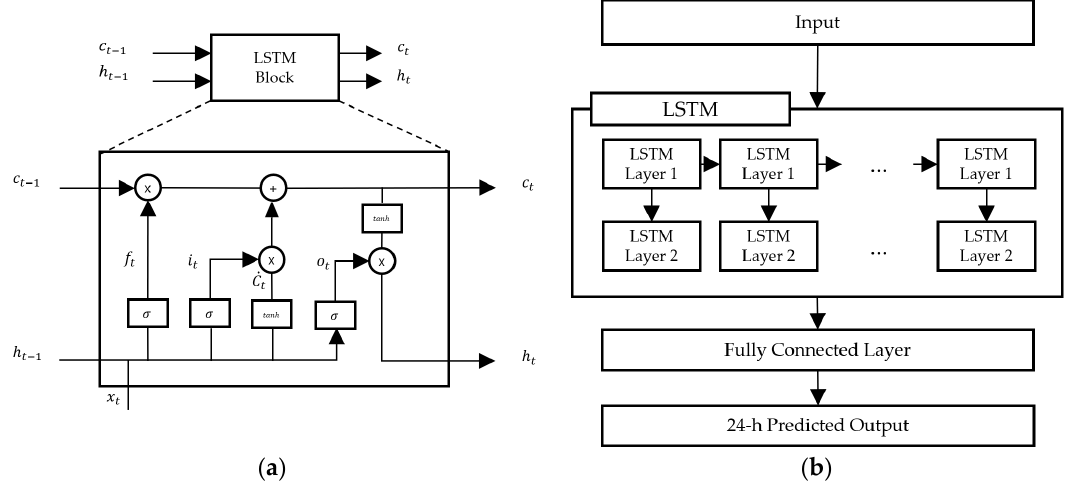
Figure 2. Long Short-Term Memory (LSTM)-based model: ( a ) the inner of the LSTM; ( b ) the LSTM-based model architecture .